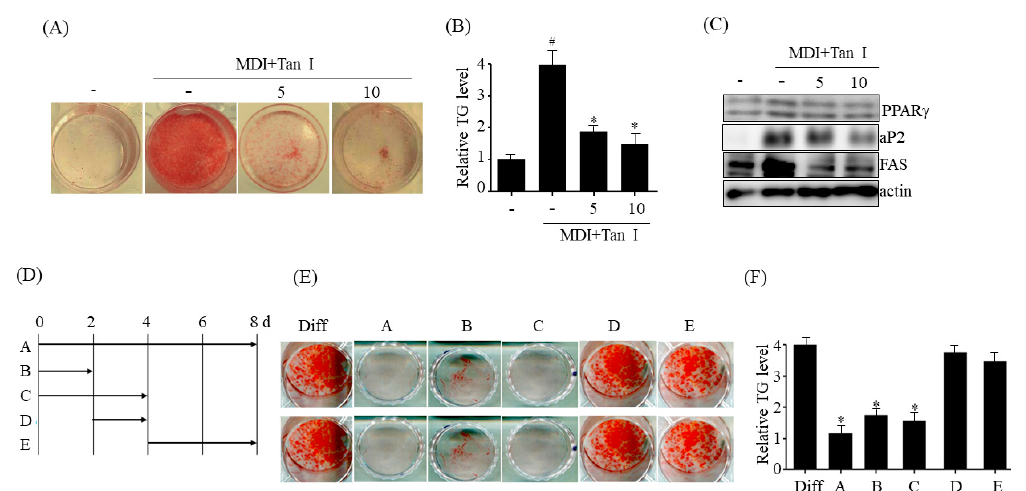
Figure 3. Tan I inhibited early adipogenesis of 3T3-L1 preadipocytes. The 3T3-L1 preadipocytes were di ff erentiated in the di ff erentiation medium (MDI) with 5 or 10 µ M Tan I for 8 days, and the adipogenesis was determined by Oil Red O (ORO) staining ( A ), intracellular triglyceride (TG) levels ( B ) and the protein levels of adipogenic markers including PPAR γ , aP2 , and FAS ( C ). The full length western blots are provided in Supplementary Figure S1. The 3T3-L1 preadipocytes were di ff erentiated in the MDI with 10 µ M Tan I on indicated periods ( D ). The adipogenesis was assessed by ORO staining ( E ) and intracellular TG levels ( F ) on indicated periods. The data are presented as the mean ± SEM of three replicate experiments. # p < 0.05 vs. undi ff erentiated 3T3-L1 preadipocytes, * p < 0.05 vs. di ff erentiated 3T3-L1 adipocytes without Tan I treatment (Diff).